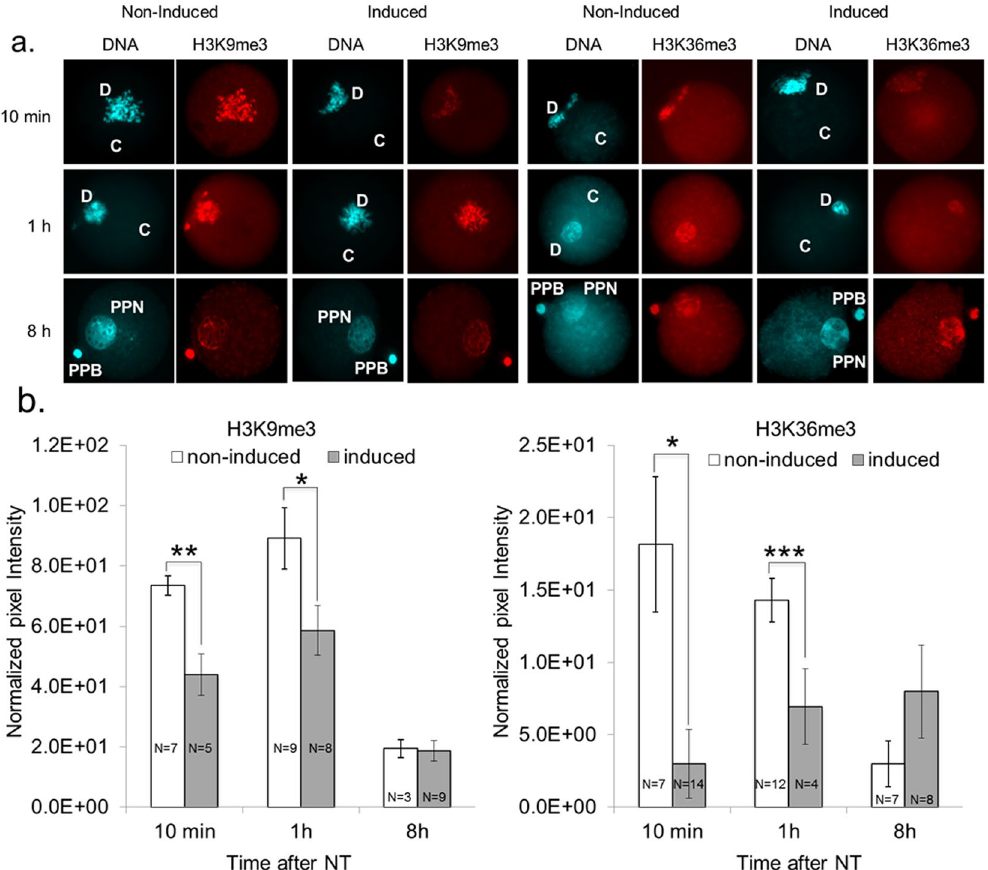
Figure 4. H3K9/36me3 levels in NT reconstructs generated from induced vs non-induced Kdm4b MEFs. ( a ) NT reconstructs were fixed and co-stained for DNA (H33342) and antibodies specific for histone modifications. Cells were analyzed 10 minutes (upper), 1 h (middle) and 8 h (lower panel) after transfer of donor DNA (D) into cytoplast (C); One-cell reconstructs were fixed and stained with H33342 (DNA) and antibodies specific for H3K9me3 and H3K36me3. PPB = pseudo polar body, PPN = pseudo-pronucleus. ( b ) Quantification of immunofluorescence analysis in ( a ). Values represent normalized pixel intensity ± SEM. N = number of NT reconstructs quantified. Different letters indicate significant differences between MEFs from the same groups (induced or non-induced) at different time points, *** P < 0.0001, ** P < 0.01, * P < 0.05 by two-tailed unpaired t-tests.